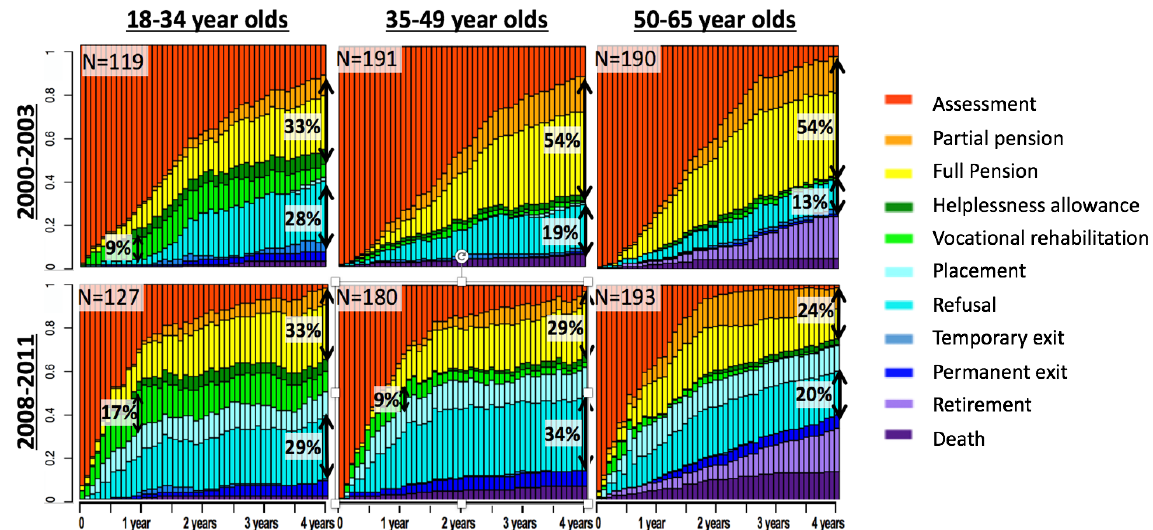
Figure 2. Comparison of two cohorts of DI claimants, according to age. Source: Rosenstein (2018; computed on the basis of administrative data provided by the DI Office of the canton of